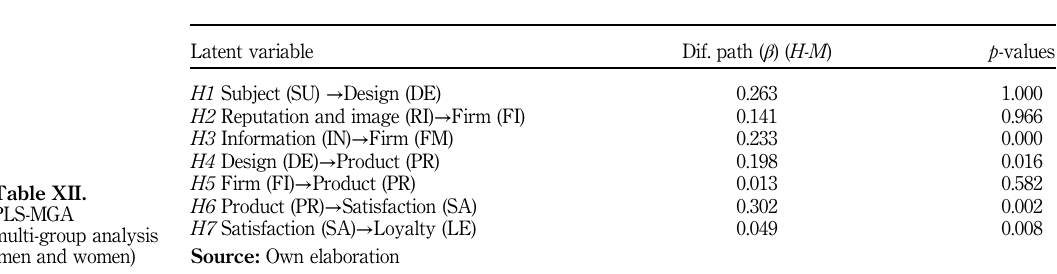
Table XI. Discriminant analysis, standardised coefficients